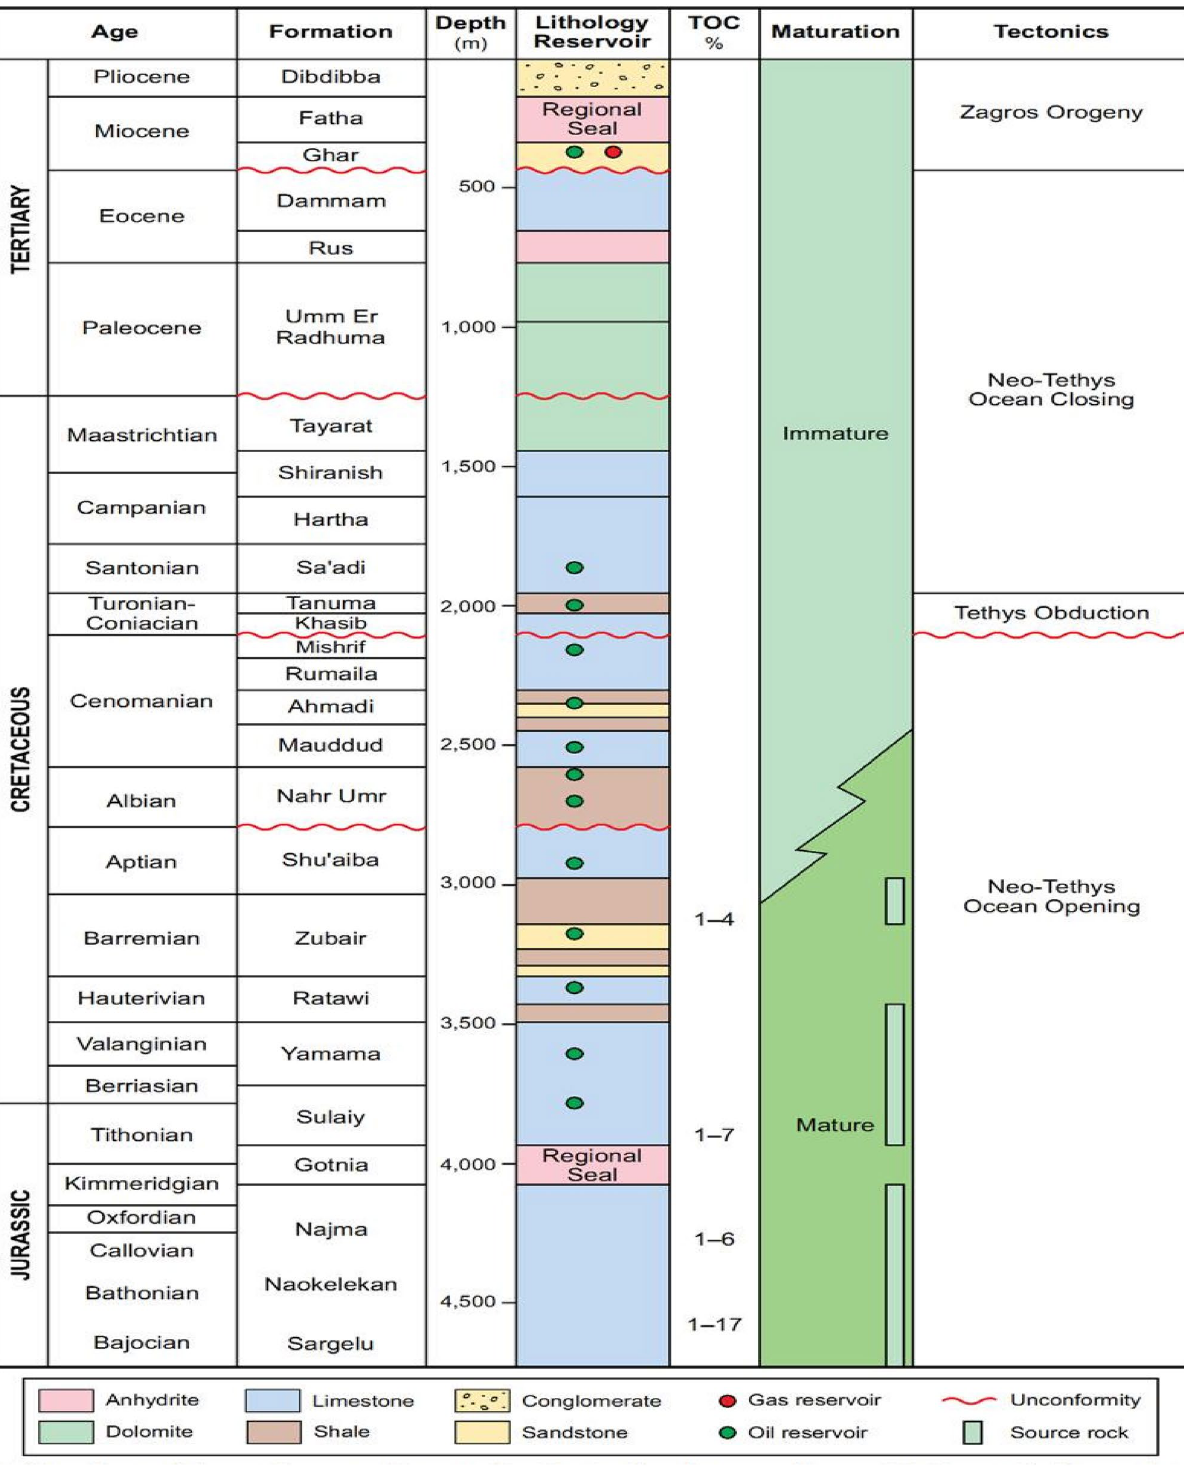
Fig. 2 Sequence stratigraphy in south of Iraq (Al-Ameri et al.